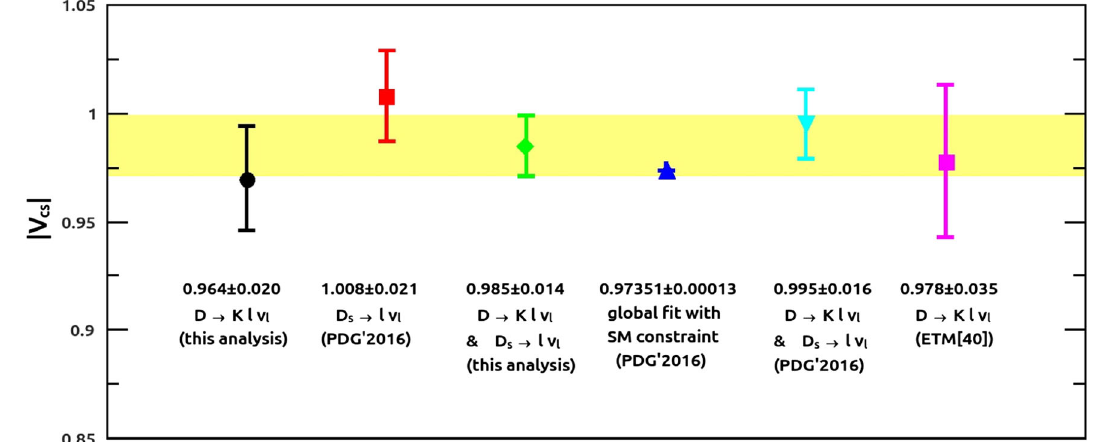
Fig. 5 The | V cs | extracted from different analysis. The yellow band is one standard deviation of the green square